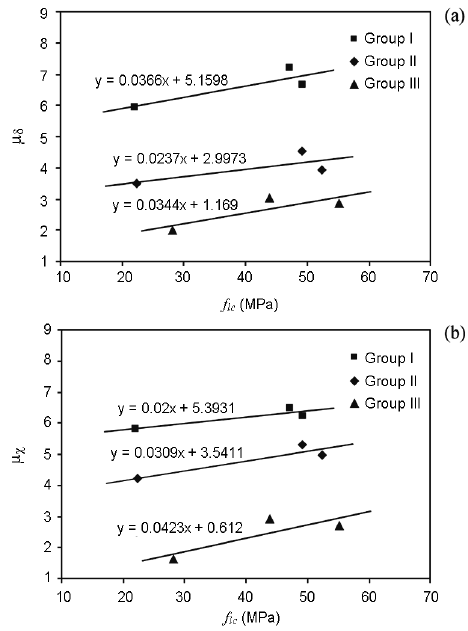
Fig. 8. Influence of reinforcement ratio on ductility: (a) index μ δ , (b) index μ